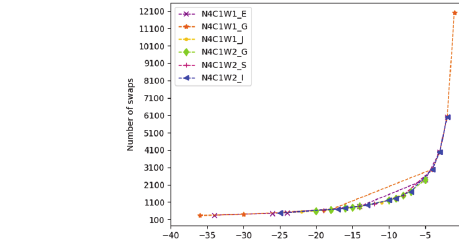
Fig. 9. Number of swaps performed by local iterative search on sample instance Algorithm 3: Pseudocode for iterative local